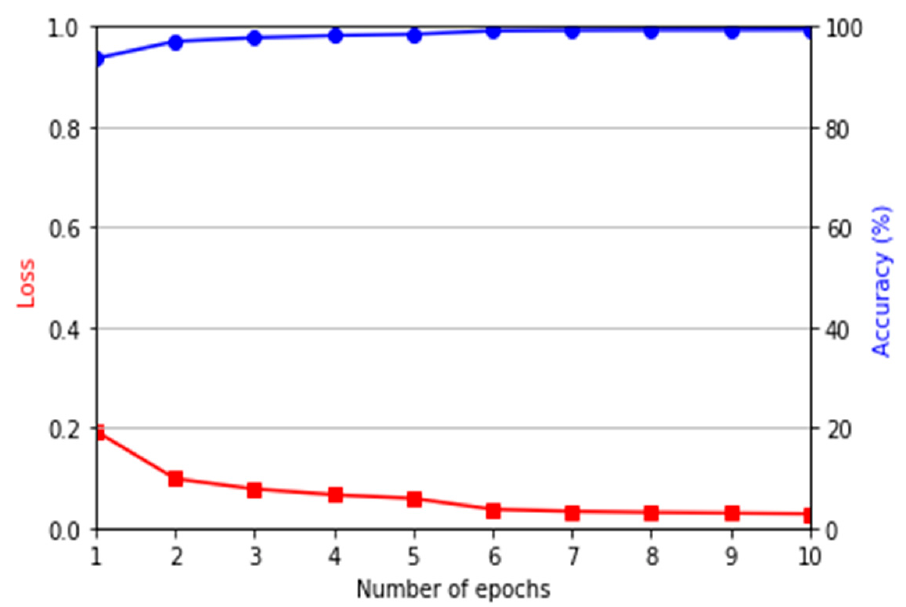
Figure 7. Graphs of the training loss and accuracy by DenseNet-161 using domain adapted data.